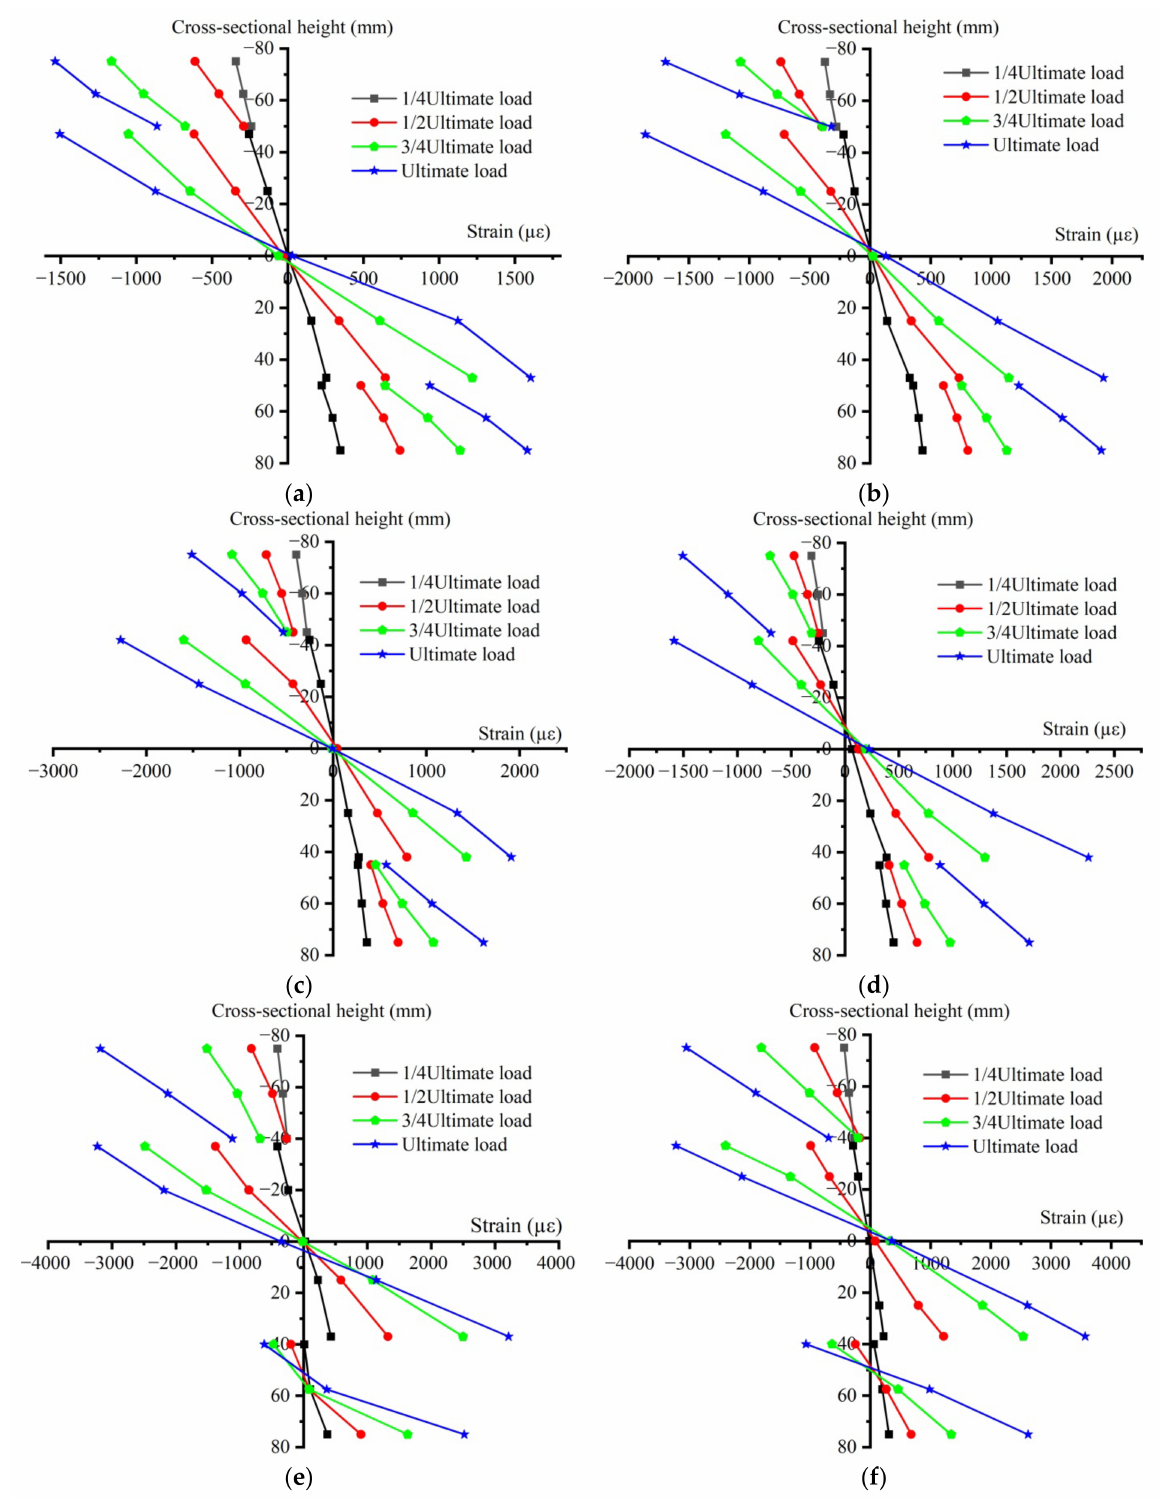
Figure 9. Normal strain diagram for mid-span section: ( a ) L1-1; ( b ) L1-2; ( c ) L2-1; ( d ) L2-2; ( e ) L3-1; ( f )